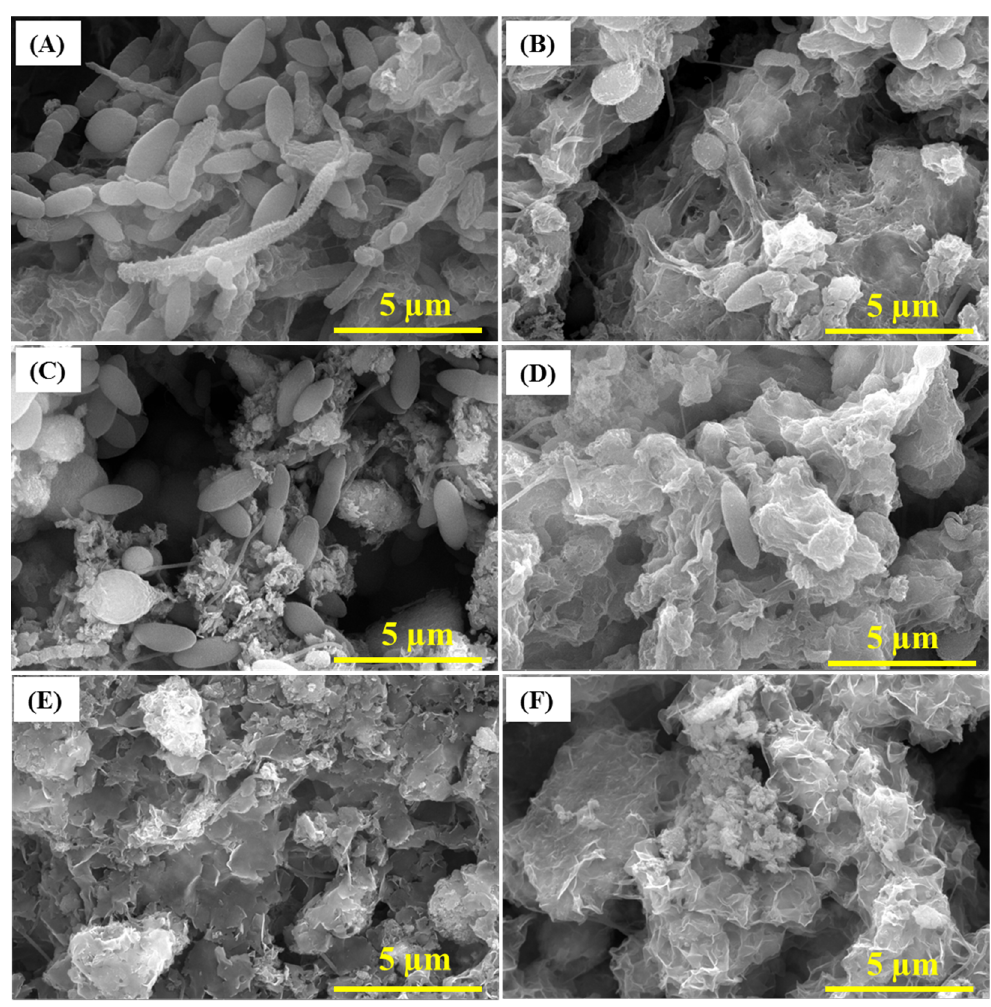
Figure 4. SEM images of the biofilm after 7 days in SRB media ( A ), 21 days ( C ) and 35 days ( E ) of incubations. SEM of the biofilm after 7 ( B ), 21 ( D ) and 35 days ( F ) in SRB media containing 500 µg·mL −1 CS/LS.